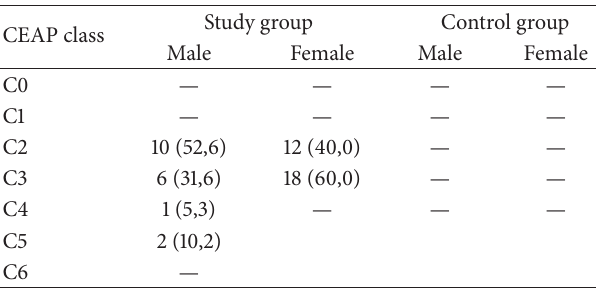
Table 2: CEAP classification of